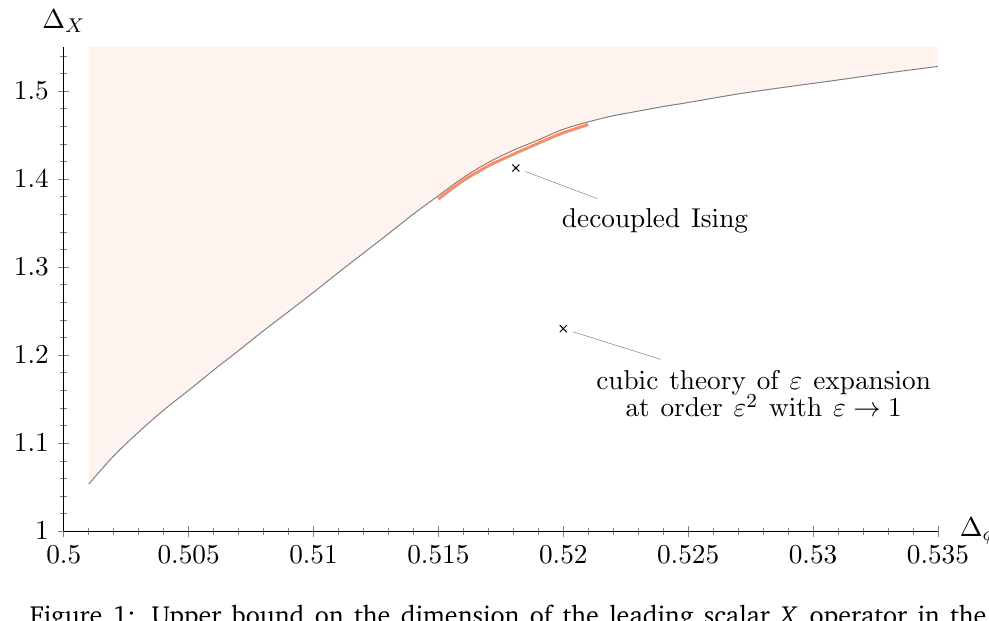
Figure 1: Upper bound on the dimension of the leading scalar X operator in the φ × φ OPE. The red area is excluded. The gray bound is obtained using PyCFTBoot i j [ 33 ] with mmax=6 , nmax=9 , kmax=36 , and lmax=26 , while the for the red bound we use stronger numerics with mmax=10 , nmax=13 , kmax=50 , and lmax=40 . The de- coupled Ising theory as well as the cubic theory of the (cid:34) expansion are also indicated in the allowed